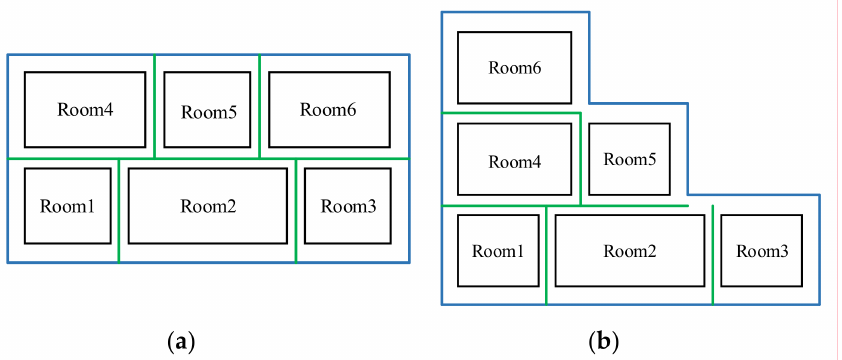
Figure 4. Simplification of walls (2D footprints). ( a ) Exterior and interior boundary surfaces of a building. ( b ) A building with irregular outer